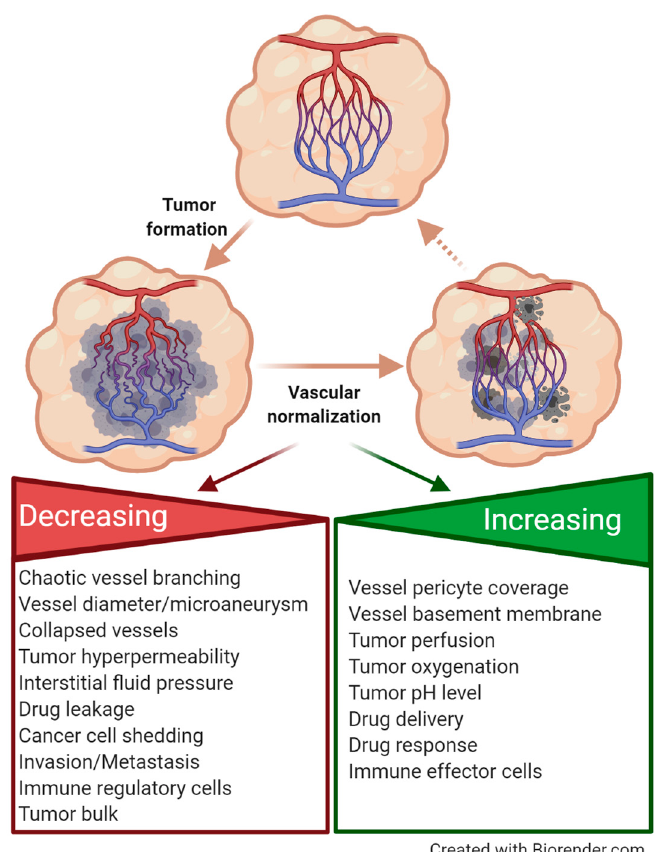
Figure 3. Vascular promotion and vessel normalization provoked by anti-angiogenic therapy. In comparison to the quiescent normal vasculature consisting of mature vessels, the tumor vasculature is structurally and functionally immature. Due to those facts, no regular blood flow is established in tumor vessels, reinforcing a hypoxic environment within the tumors, the extravasation of detached tumor cells into the blood or lymphatic system, and the infiltration by immune regulatory cells. In response to anti-angiogenic therapy, the balance of anti-angiogenesis and pro-angiogenesis is brought back to near normal, achieving vascular normalization. These observations changed the paradigm in cancer therapy from anti-angiogenic strategies to vascular promotion/normalization therapy in order to enhance blood flow and, consequently, increase the delivery and intracellular uptake of chemotherapeutic drugs.